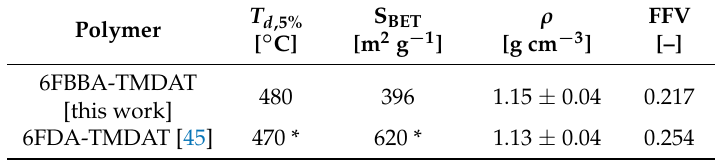
Table 1. Physical properties of 6FBBA-TMDAT polyamide. Degradation temperature at 5% weight loss ( T d ,5% ), film density ( ρ ), surface area (S BET ), and fractional free volume (FFV). (*) Data reported for